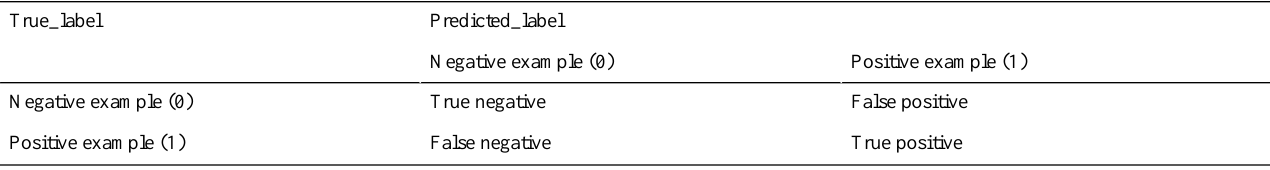
Table 3. Confusion matrix. Predicted_labelTrue_label